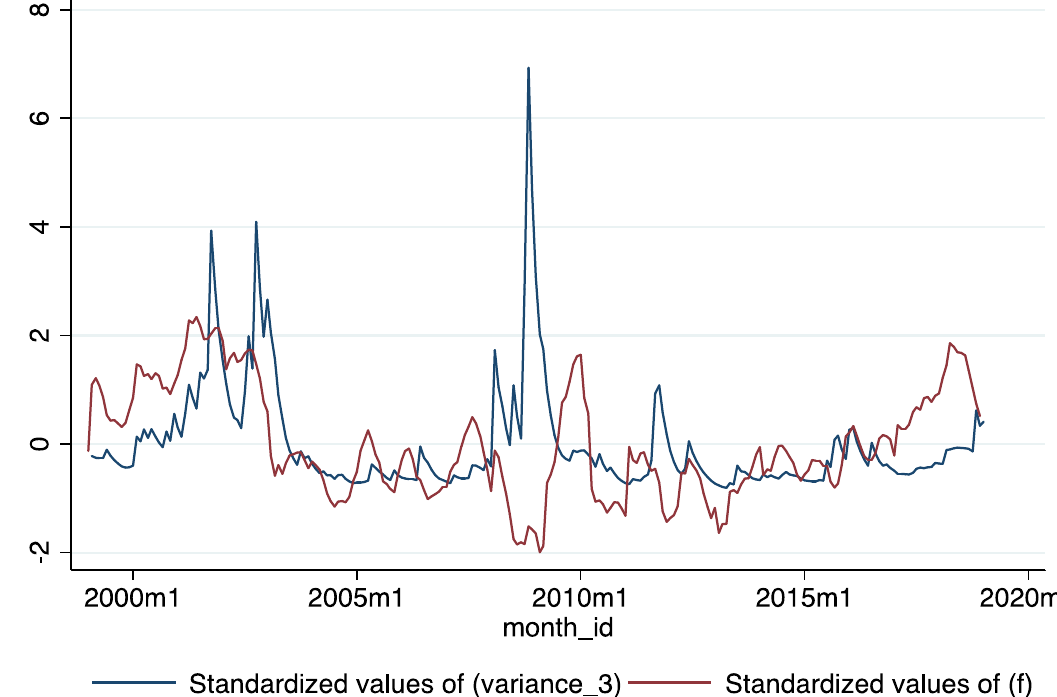
Figure 2. Standardized Stoxx600 returns variance obtained from the ARCH model and standardized sentiment index ( stdf )